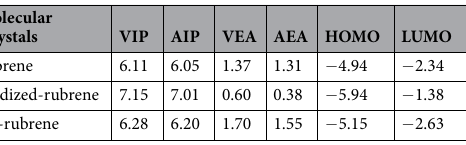
Table 4. VIPs, AIPs, VEAs, AEAs, HOMO energy levels, and LUMO energy levels calculated at the B3LYP/6– 311 ** level